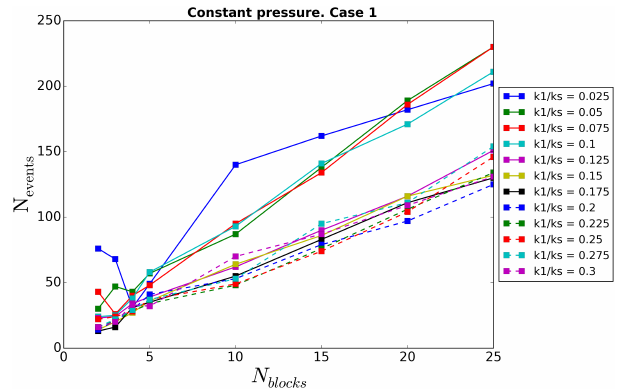
Figure 8. Maximum seismic moment of event vs. number of blocks.